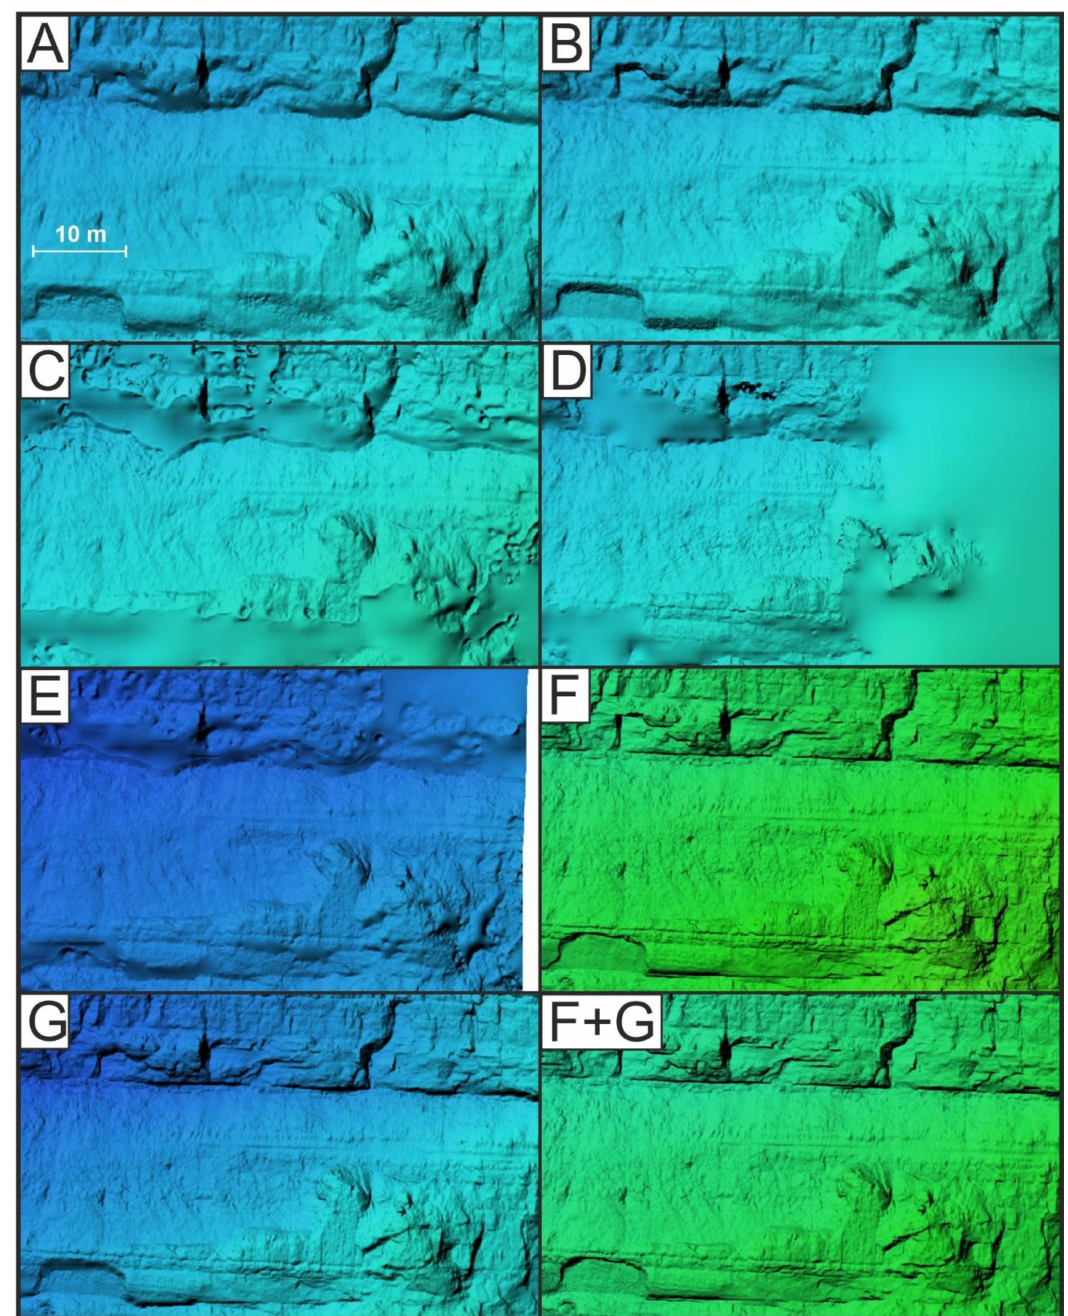
Figure 5. Details of the Digital Elevation Models obtained from the different SfM-UAV surveys. ( A ) AMSL-nadir; ( B ) AMSL- 40 ◦ off-nadir; ( C ) AGL-nadir; ( D ) AGL-40 ◦ off-nadir, ( E ) AGL-Point of Interest; ( F ) facade-nadir; ( G ) facade-40 ◦